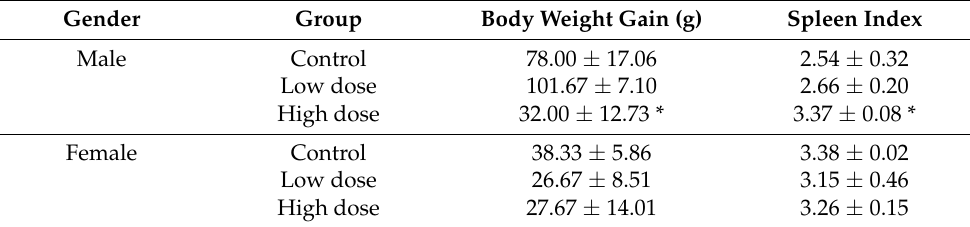
Table 2. Effect of HCFP on body weight and immune organ after 14-repeated day administration in male and female Wistar rats.